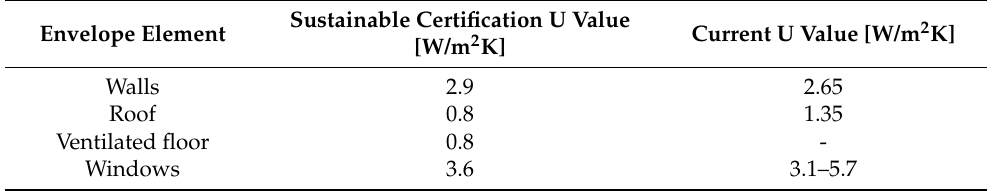
Table 4. Maximum allowed values of the thermal transmittance for the envelope elements according to the sustainable building certification and the actual values of the thermal transmittances.